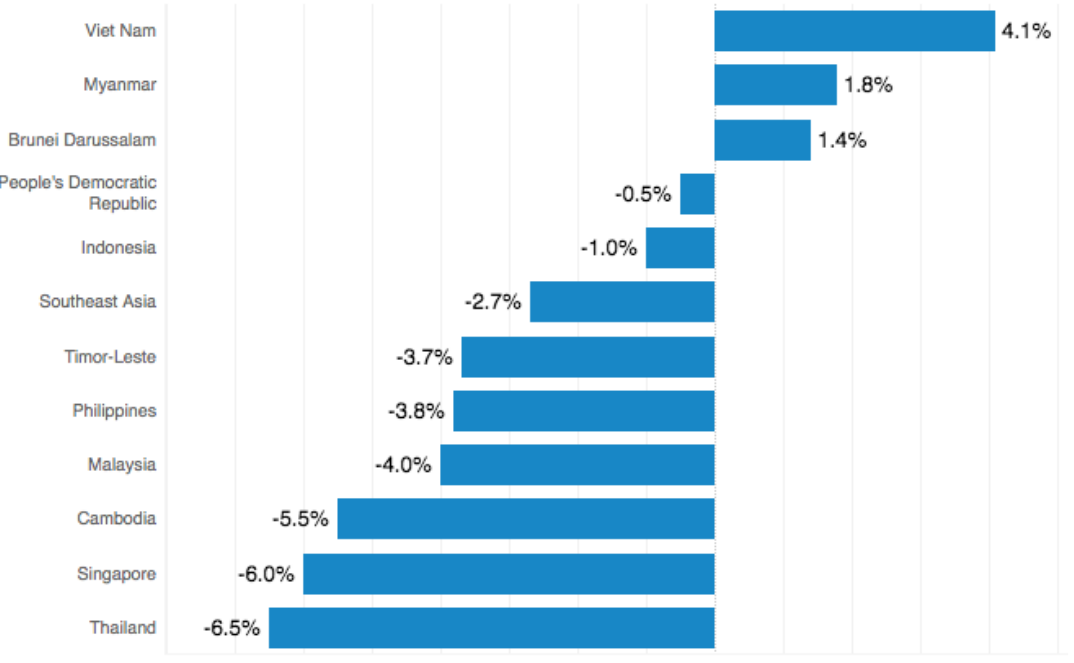
Figure 7: GDP Growth Rate, 2020 Forecast (% per